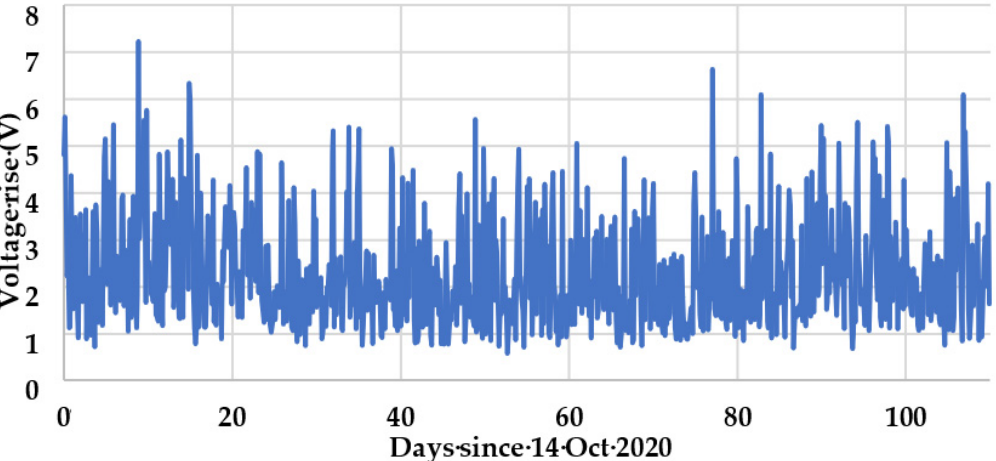
Figure 4. Difference between the highest 1-cycle rms voltage and the 3-h rms voltage, for the group “overvoltage”.